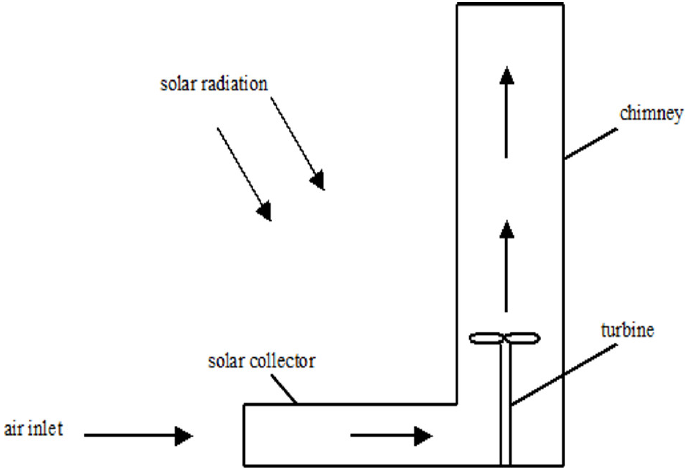
Figure 1. Solar chimney.